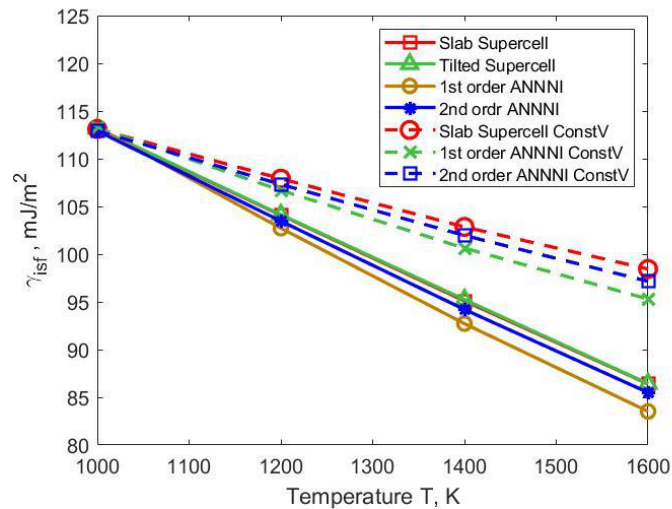
Figure 11. Temperature-dependent intrinsic stacking fault energy along [112] direction of FCC paramagnetic nickel.